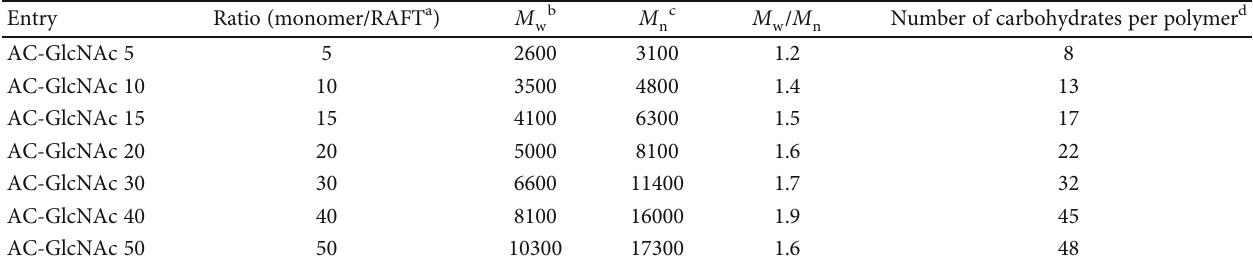
Table 1: Polymerization of AC-GlcNAc monomer using reversible addition-fragmentation chain transfer (RAFT)